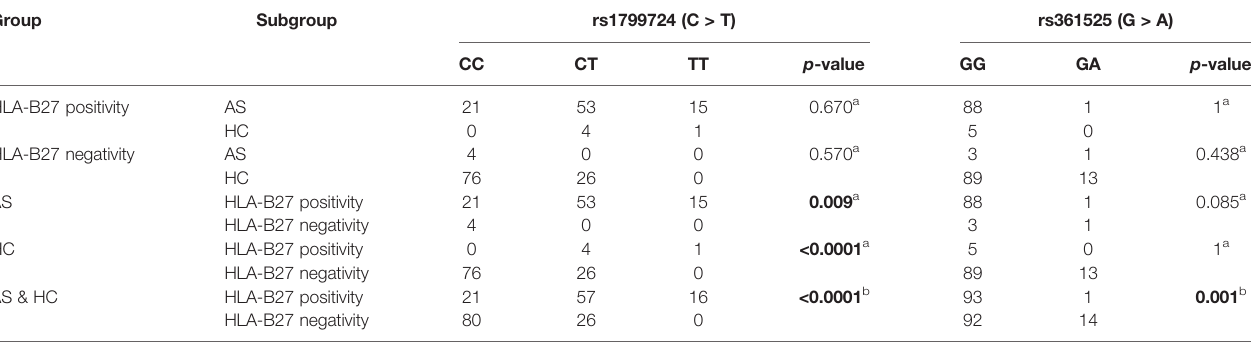
TABLE 3 | Genotype distributions of rs1799724 and rs361525 in different groups based on HLA-B27.